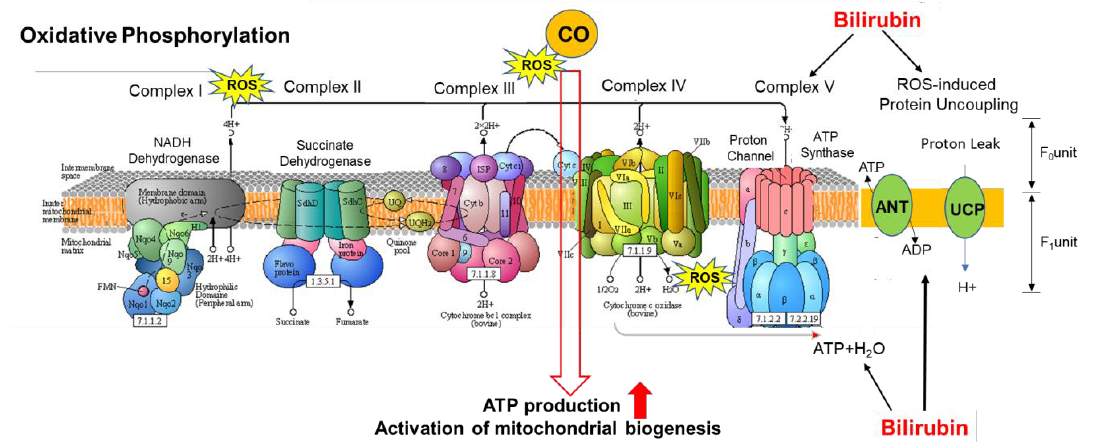
Figure 6. As ATPase activity increases, more electrons and protons permeate through the mitochondrial membrane into the matrix, leading to the formation of ROS. Molecules such as uncoupling proteins (UCPs), and adenine nucleotide translocases (ANTs) uncouple these reactions counteracting ATPase’s increased activity lowering the formation of ROS with increased thermogenesis. Furthermore, the ROS formed by COVID-19′s “cytokine storm” create inflammation that is destructive to the mitochondria in the electron transport chain (ETC). If insufficient mitochondria in cells is evident, such as in white adipose cells, these cells are unable to accommodate the severe ROS formed leading to overwhelming inflammation. Brown adipose cells are better at handling ROS due to higher concentrations of mitochondria. CO increases ATP production and activates mitochondrial biogenesis [85–87] and bilirubin blocks ROS action and increases resistance to hepatic steatosis. [88,89] .